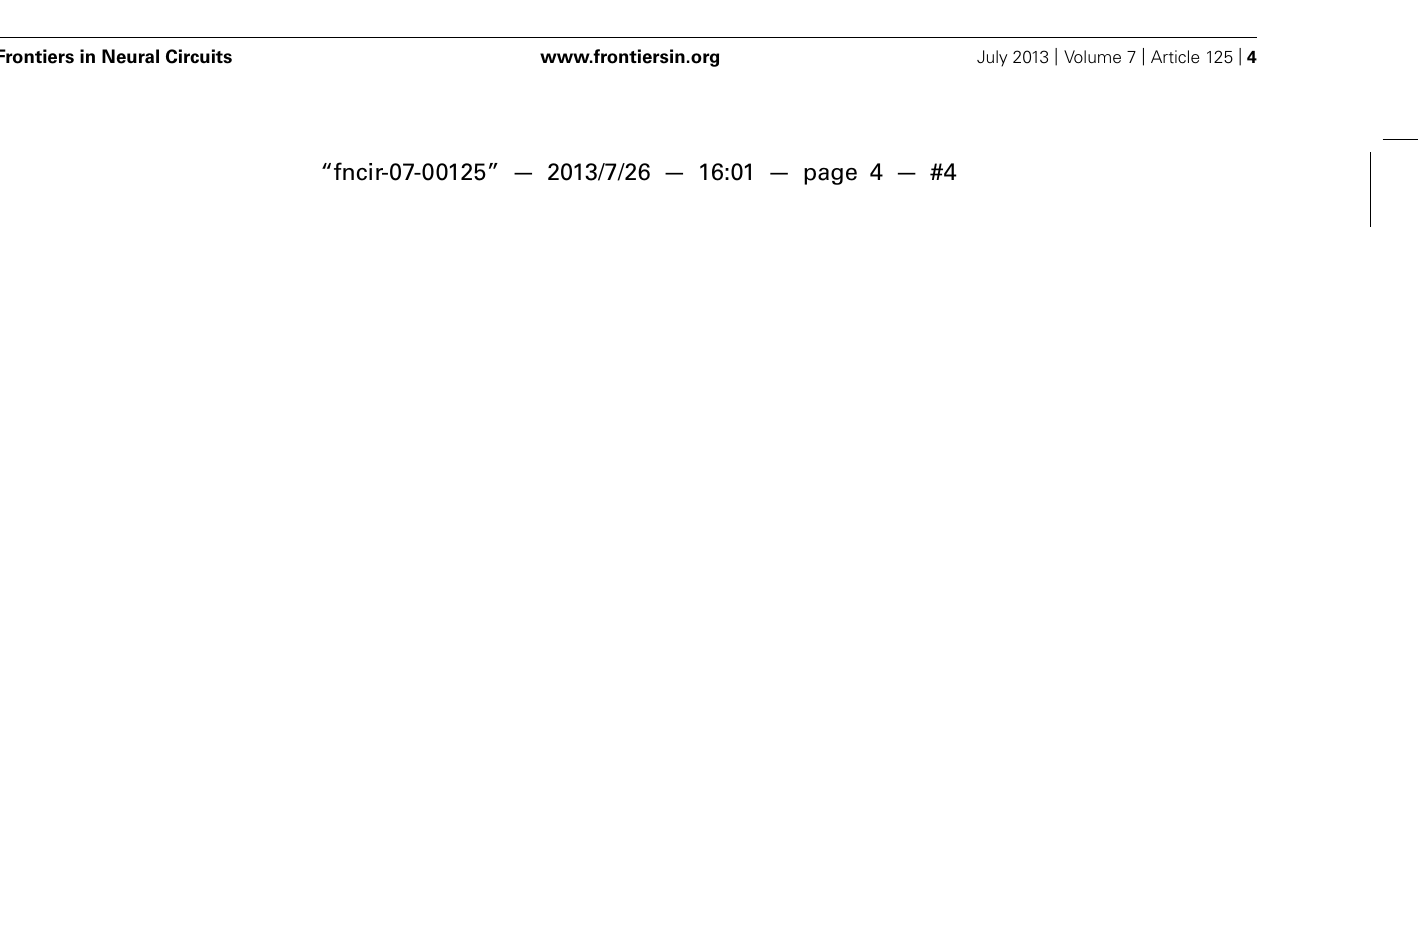
taken. (B) Cerebellar circuitry, with an emphasis on the potential interaction sites between different oscillatory phenomena. Highlighted are the Purkinje cell (PC) afferent region (1), the deep cerebellar nuclei (2, DCN), and the Golgi cell (Go)–granule cell (Gr) circuits in the GCL (3). Interactions are discussed in the text. IO, inferior olive; MF, mossy fiber; PF, parallel fiber; SC, stellate cell; BC, basket cell, the latter two provided for